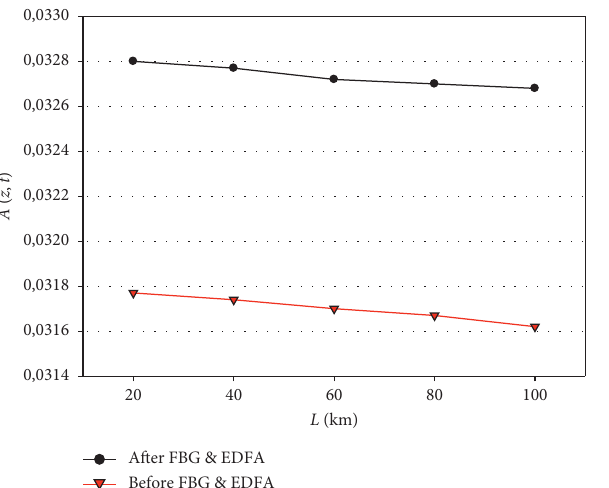
Figure 10: Output signal amplitudes variation at different values of optical fiber length.